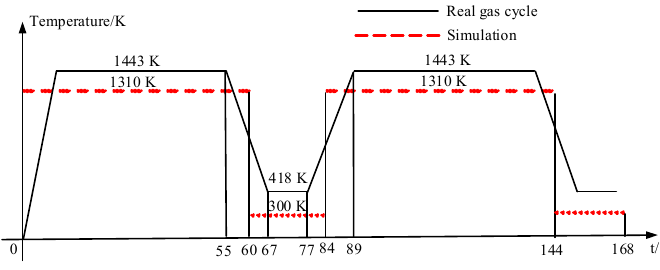
Figure 9. Typical gas cycle profile of the thermal fatigue test [38].